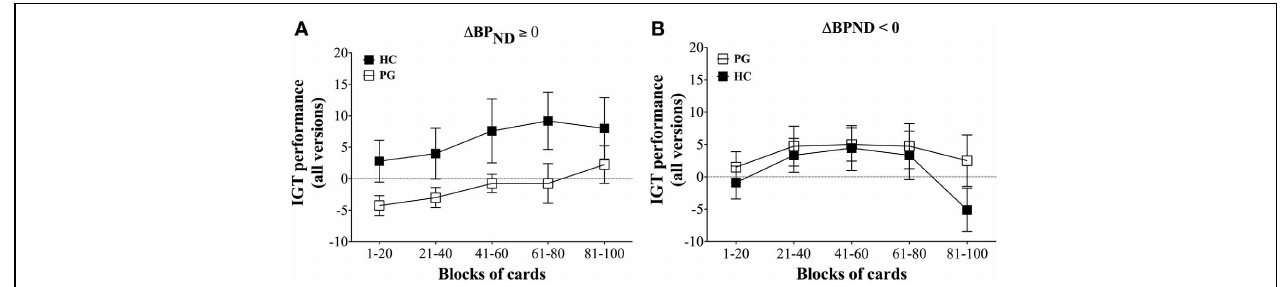
ordinate shows the IGT performance across all versions. Mean and Standard Errors are illustrated in the squares and error bars, respectively. (B) (cid:2) BP ND < 0. Healthy controls (HC, black squares, n = 9) with increased binding potentials ( (cid:2) BP ND ≥ 0) do not differ in IGT performance on the ABCD version compared with gambling disorder sufferers (PG, white squares, n = 8), F ( 5 , 17 ) = 1 . 78, ns. Reprint with permission from Linnet et al.